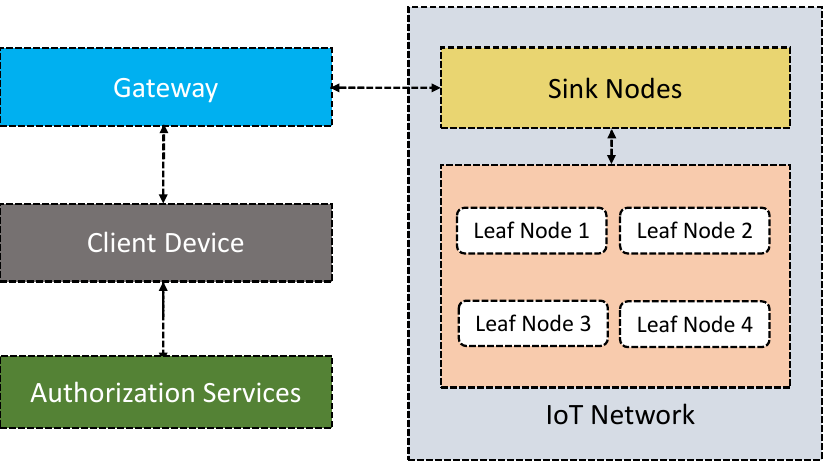
Figure 3. An outline of the proposed ProBAC model discussed in